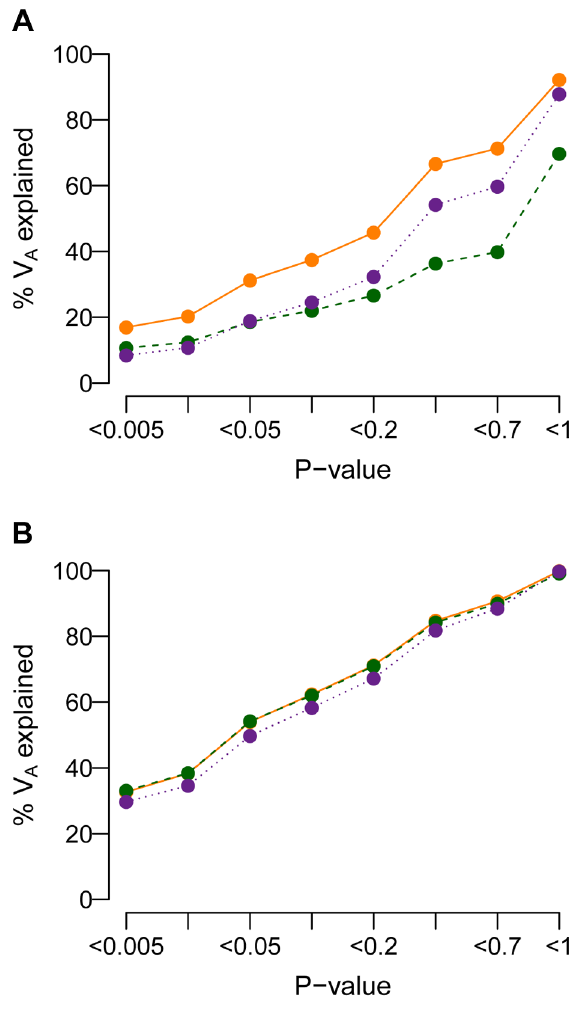
Figure 8. Cumulative distribution of the amount of the additive genetic variance of a trait ( V A ; y -axis) explained by SNPs with a single-marker association test P -value less than a given threshold ( x -axis). ( A ) A SNP’s effect on the trait is correlated with its effect on fitness ( t =0.5). Note that the population that experienced recent growth (green line; BN + growth) has a lower proportion of V A accounted for by SNPs at any P -value threshold than the populations that did not recently expand (orange and purple lines; BN and Old growth). ( B ) A SNP’s effect on the trait is independent of its effect on fitness ( t =0). Here note that the SNPs with low P -values ( , 0.05) account for most of the V A regardless of the demographic history of the ~ 0 : 05 and M =70 population. Here h 2 C